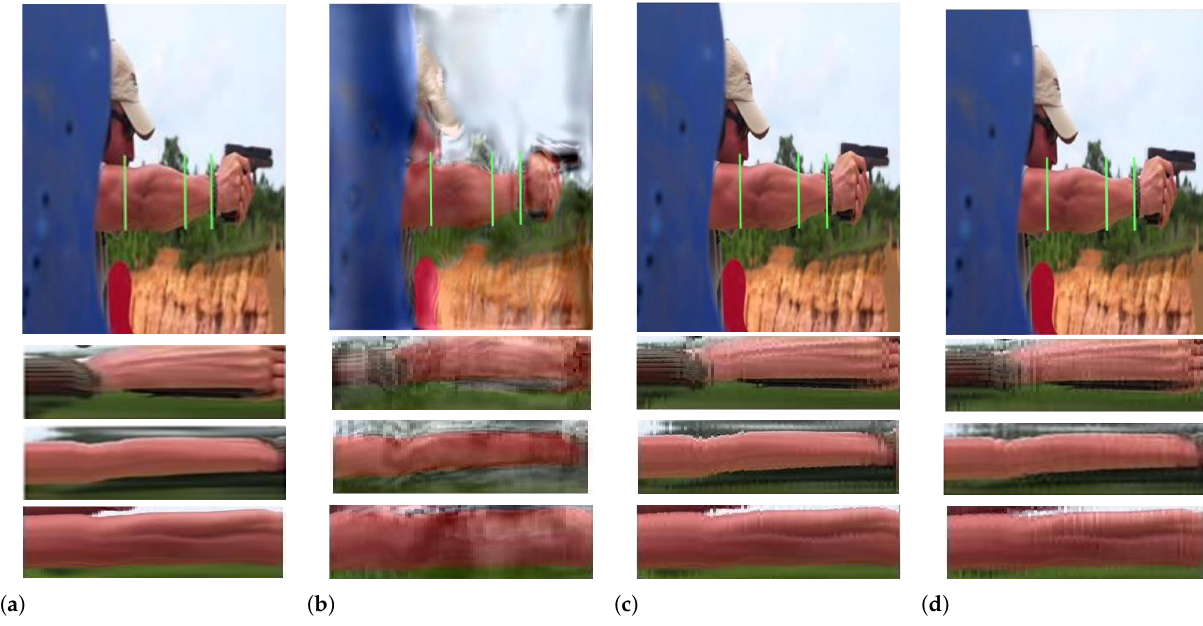
Figure 5. In the gun shooting sequence, the strong recoil causes small vibrations of the arm. The spatio-temporal slice is shown at different positions with three green lines over the sequence for each processing. ( a ) Original video frame. ( b ) Phase-based video magnification. ( c ) Eulerian-acceleration magnification. ( d ) Our proposed spectrum-aware magnification. The Eulerian-acceleration approach only magnifies the nonlinear motion by linking the response of a second-order Gaussian derivative, whereas the phase-based method results in large blurs and artifacts. Our proposed method magnifies the arm movements correctly without being affected by the background clutter